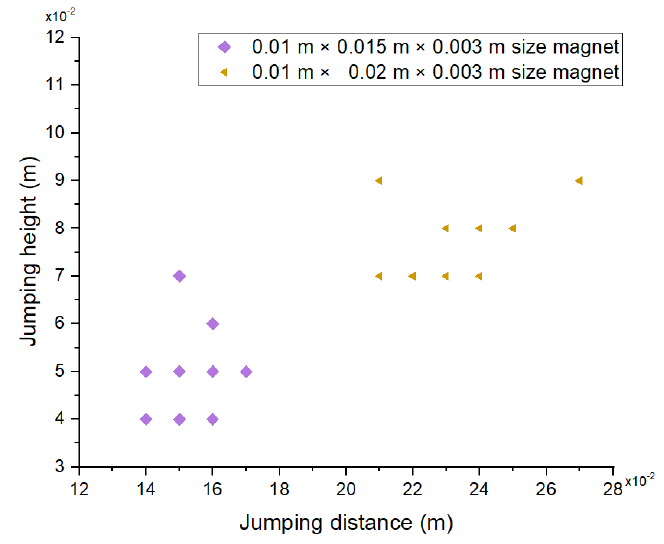
Table 5. Conditions for the robot used in the comparison of jump forces depending on the volume of air injected test.